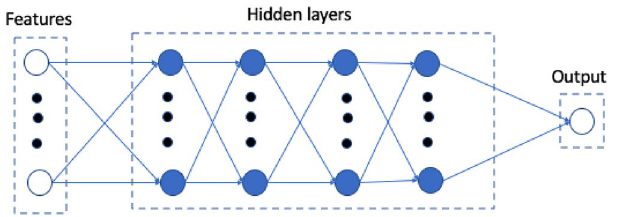
Figure 1. The feed forward DL model used for prediction of LV volume, pressure and